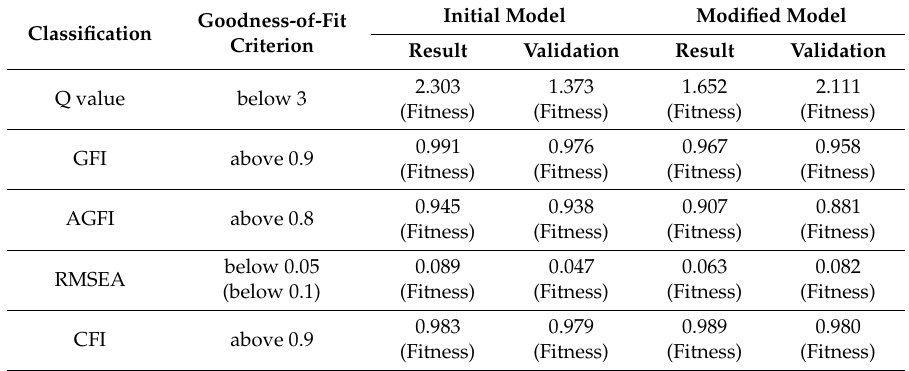
Figure 3. Developed path model for effluent T–N concentration. (dashed line: insignificant path coefficient, ***: p -value < 0.001). ( a ) Initial path model; ( b ) modified path model. Table 3. Fitness results of developed path models for effluent T–N concentration.